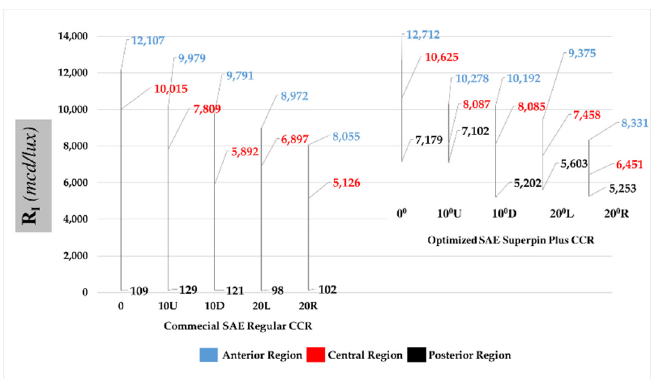
Figure 20. Comparison of the commercial regular CCR with the optimized design SuperPin Plus CCR’s coefficient of luminous intensity R I by region. (ECE curved CCR).